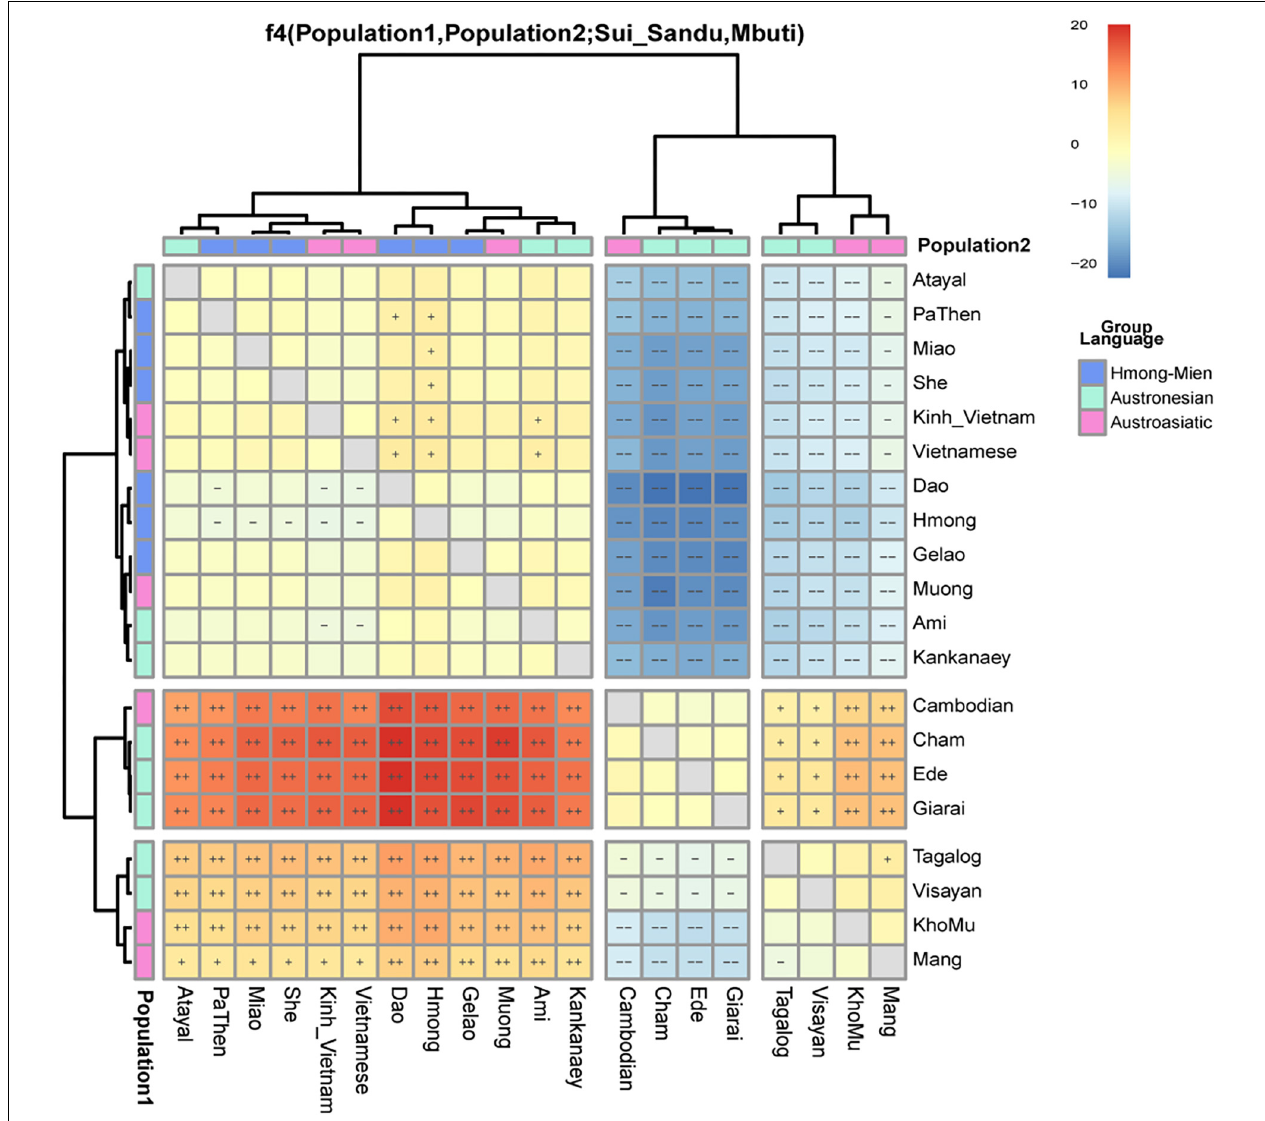
FIGURE 5 | Genetic affinity between Guizhou Sui and southern populations shown in f 4 (population1, population2; Sui_Sandu, Mbuti) . Significant Z scores were labeled by “++” “– –” ( Z > 6, Z < –6, respectively), and Z -values with 3 < Z < 6, –6 < Z < –3 were labeled by “+,” “–,”